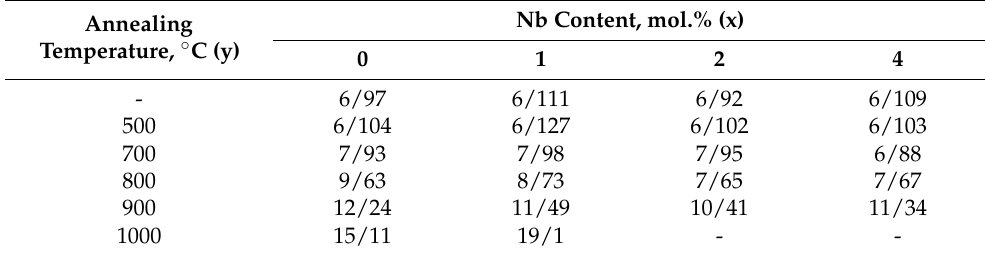
Table 1. Morphological parameters of the obtained materials—grain size, nm/surface area—m 2